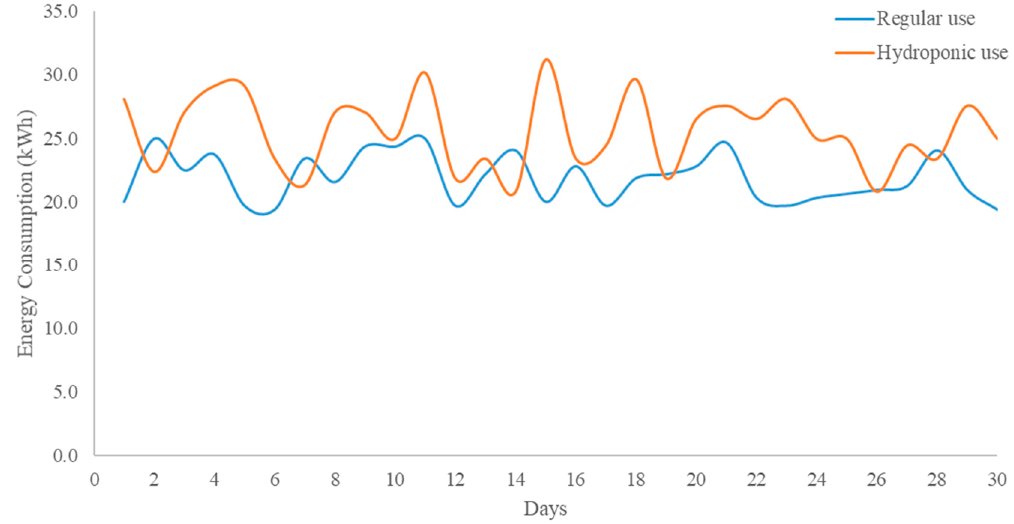
Figure 11. Daily energy consumption due to hydroponic system in comparison to regular use.